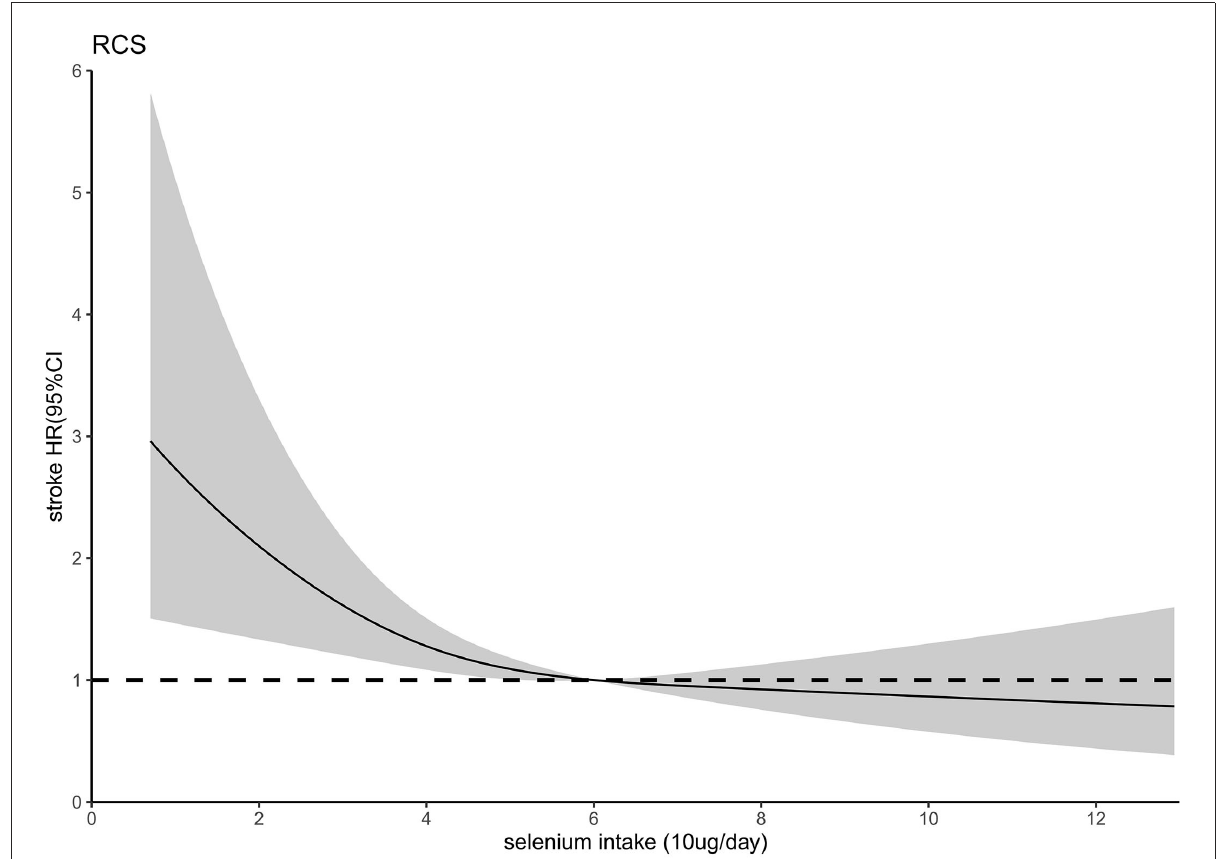
FIGURE2 Relation of selenium intake with risk of developing stroke. Adjusted for age, gender, race, energy intake, site, marital status, education level, activity level, smoking status, drinking status, BMI, hypertensions, myocardial infarction, diabetes, dietary fiber, niacin, vitamin C, vitamin E, calcium, iron, zinc, magnesium, copper, and